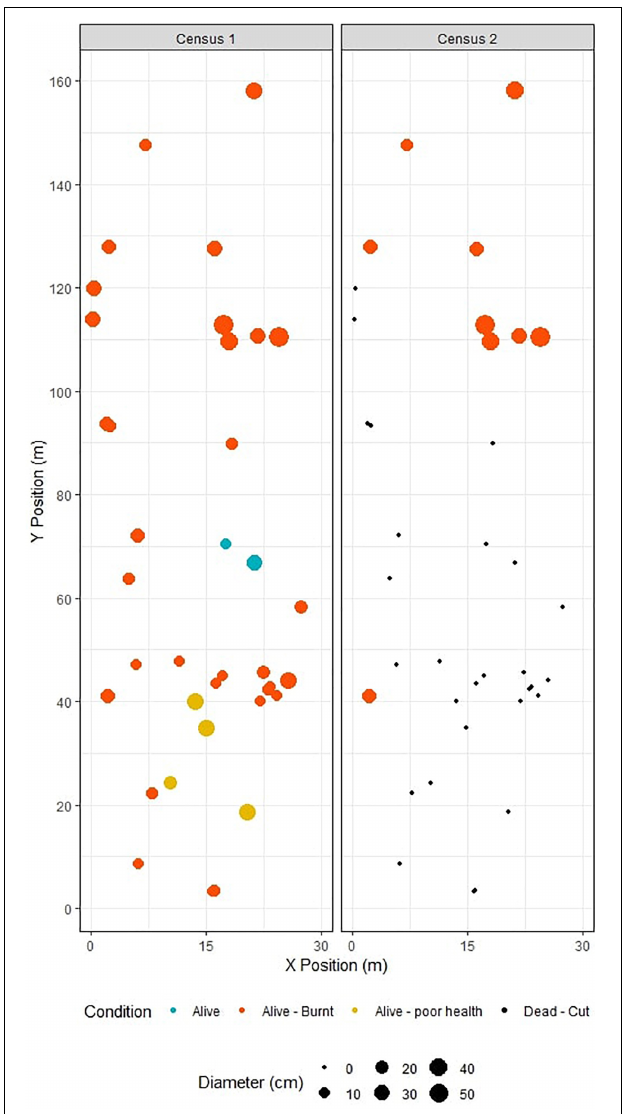
FIGURE 6 | Example map of plot 8 in census 1 and census 2, showing live trees in census 1 and degradation in census 2. Maps show location of trees within plot, colours show condition of individual trees, size of point shows DBH (cm). Figure is not to